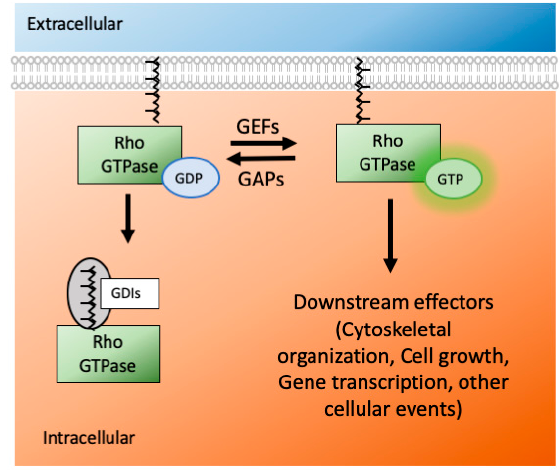
Figure2. TheRhoGTPasesactasmolecularswitchesinthecellularenvironment. Theyareactivewhenthey are GTP bound and inactive when they are GDP bound. GAPs and GEFs do the exchanges between GTP and GDP. When not active, the Rho GTPases remain in the cytoplasm using GDIs. Via geranylgeranylation using the enzyme GGT, they appear on the surface of the plasma membrane. (GDP-guanosine diphosphate, GTP-guanosine triphosphate, GAP-GTPase activating protein, GEF-guanosine activating factors, GDI-guanosine dissociation inhibitor, GGT-geranylgeranyl transferase). Rho GTPases are activated by GEF proteins and inactivated by GAPs. A GEF binds with